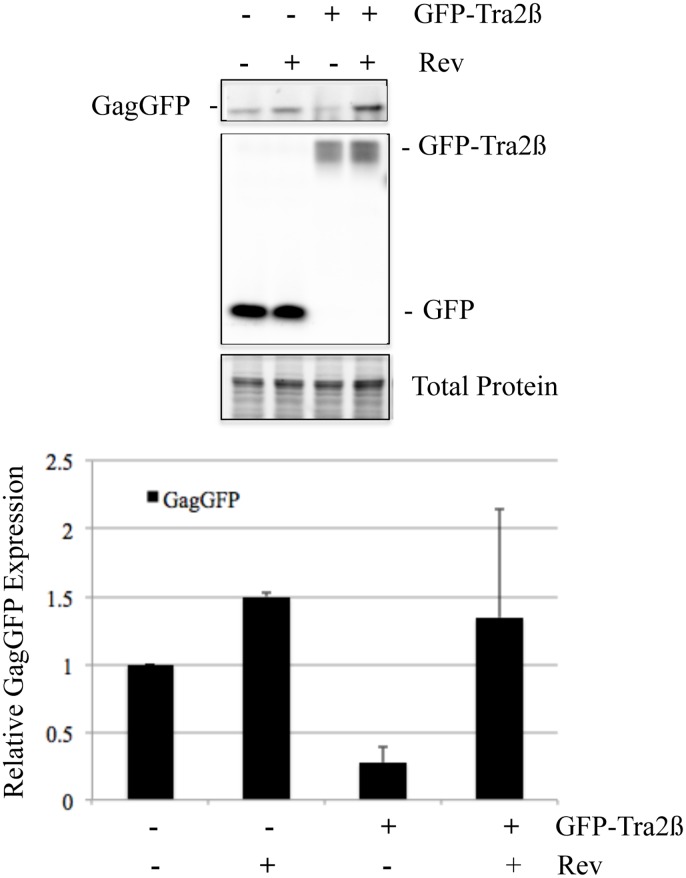
Rev Overexpression Reverses the Repression of HIV-1 Gag by Tra2β.HEK 293T cells were transfected with HIV-1 proviral clone pNL4-3 GagzipGFP in the presence of either plasmid expressing GFP or GFP-Tra2β with (+) or without (-) a Rev-expression vector. Forty-eight hours post transfection, cells were harvested and extracts analyzed on SDS-PAGE gels. GFP signals for GagGFP, GFP, and GFP-Tra2β were imaged directly using a Bio-Rad MP imager. Total protein loading was verified using Stain-Free gels (Bio-Rad). At top is a representative assay and bottom, a summary of results from n>3 independent assays.